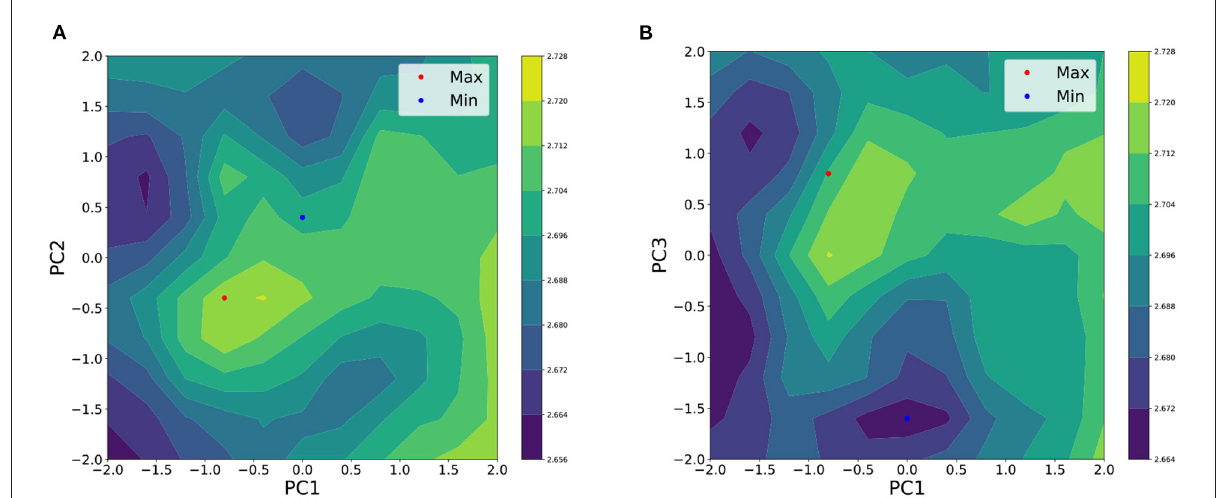
FIGURE5 Averaged utility function of perceived cuteness on (A) PC1 and PC2 and (B) PC1 and PC3. The height of each surface describes the strength of the perceived cuteness. Red dots represent the PC score corresponding to the maximum of the function and blue dots represent the PC scores corresponding to the